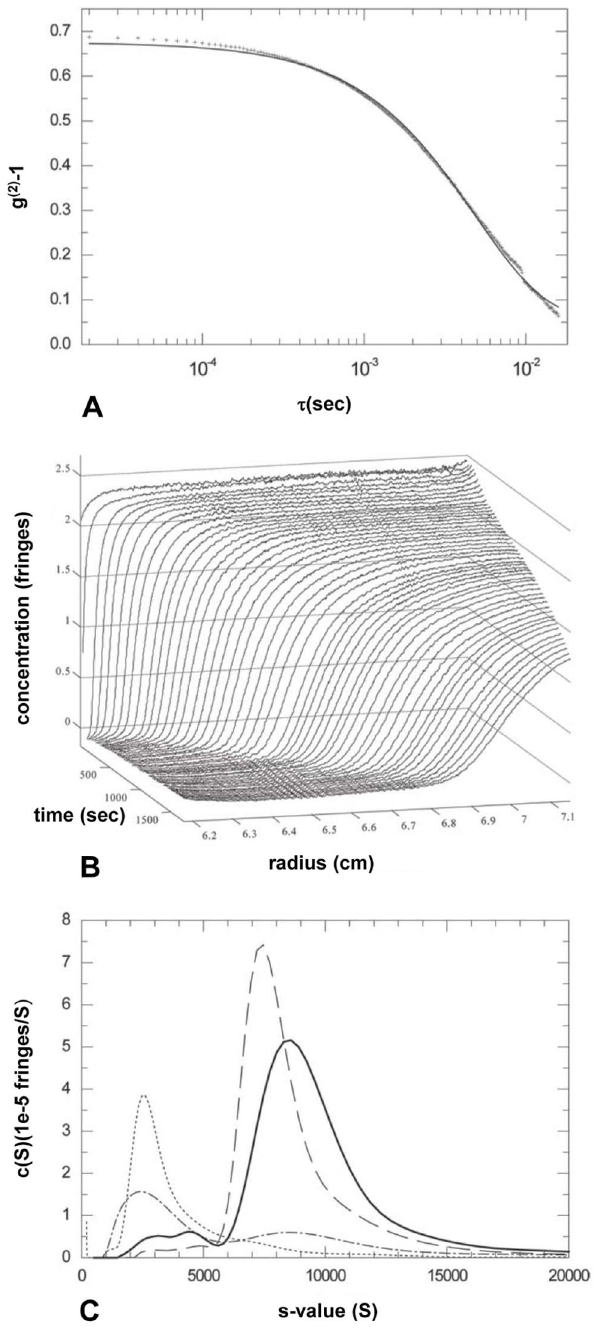
Figure 4. Hydrodynamic studies of a Spiroplasma cell popula- tion. [A] Dynamic light scattering of live Spiroplasma cells in isotonic PBS. Shown is the autocorrelation g (2) -1 function acquired at 90 u (crosses) overlaid with the best-fit single species fit (solid line). The data estimate an average diffusion constant of 6.1 6 10 2 9 cm 2 /sec. [B] Evolution of concentration profiles across the Spiroplasma sample in PBS at various times after the start of centrifugation at 3,000 rpm. [C] Sedimentation coefficient distributions calculated by least-squares modeling of the concentration distributions in [B] by superposition of Lamm equation solutions of non-diffusing species, ls-g*(s) . Shown are the distributions obtained at Spiroplasma concentrations of 0.015 mg/ ml (dash-dotted line), 0.15 mg/ml (solid line), 1.5 mg/ml (dashed line) and buffer (dotted line).